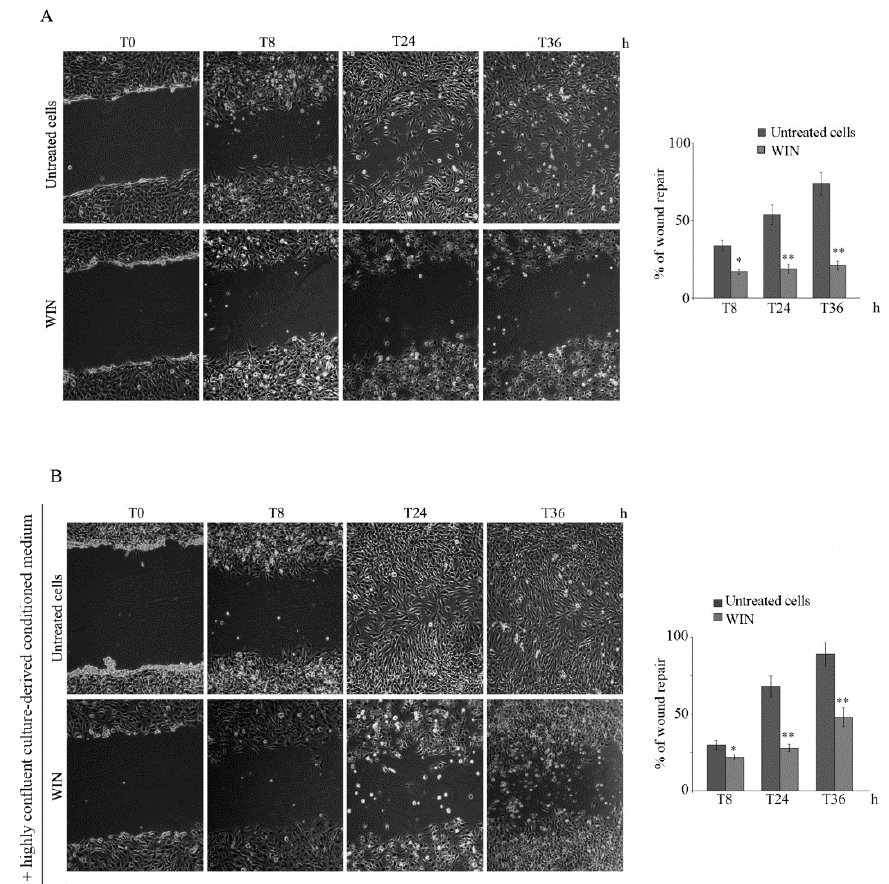
Figure 1. WIN55,212-2 (WIN) treatment inhibits MG63 cell migration. The effect of WIN on MG63 wound healing in the absence ( A ) or presence of conditioned medium ( B ). After mechanical wounding, confluent cells were treated with 5 µ M WIN and cell migration was monitored over time. In ( B ), before treatment, cell culture medium was replaced with conditioned medium from high confluence cultures. Representative microphotographs were taken at the indicated time points after wounding (magnification 200 × ). The average distances between cells at the edges of the gaps in the wound healing assay were estimated by ImageJ software. Histograms reporting the mean percentage area healed at T8, T24 and T36 post-wounding are shown on the right panels. (*) p < 0.05 and (**) p < 0.01 versus untreated cells at the same time point.